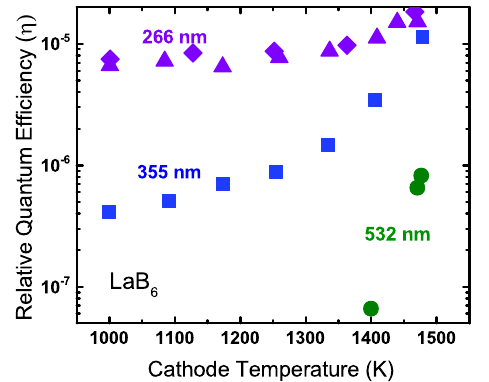
FIG. 8. Calculation of cathode temperature rise by incident laser pulse energy. Cathode material LaB 6 at 1500 K. Laser wavelength 532